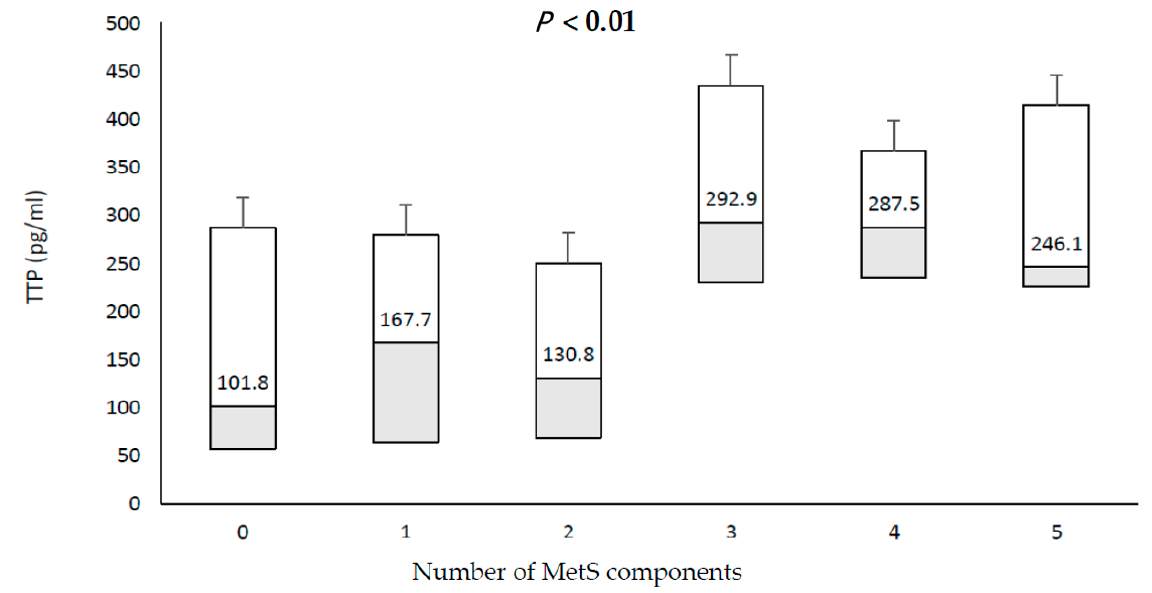
Figure 1. Comparison of serum TPP levels between the individual MetS component in MetS patients and healthy controls.